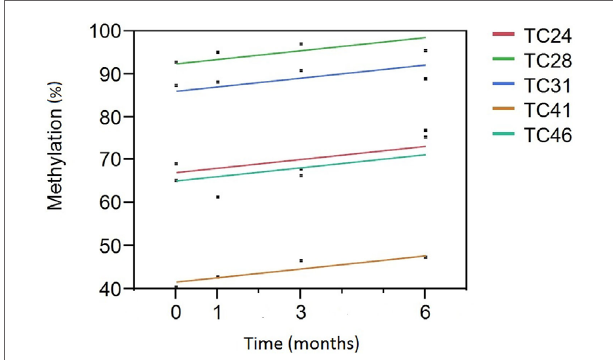
FigUre 1 | a Plot of cg05575921 methylation as a function of time from smoking cessation intake/quit point . Percent methylation, as indicated by the qPCR assay, is given on the Y axis. Time (in months) of the blood draw relative to the inception of the subject into the study and hopefully their efforts to reduce smoking is given on the X axis. Each of the subjects had negative cotinine and exhaled CO levels at the 3- and 6-month time points. The linear fit of the reversion curve for each subject is denoted by the color in the figure legend. For example, the best fit line for tobacco cessation (TC) subject 31 (TC31) is shown in